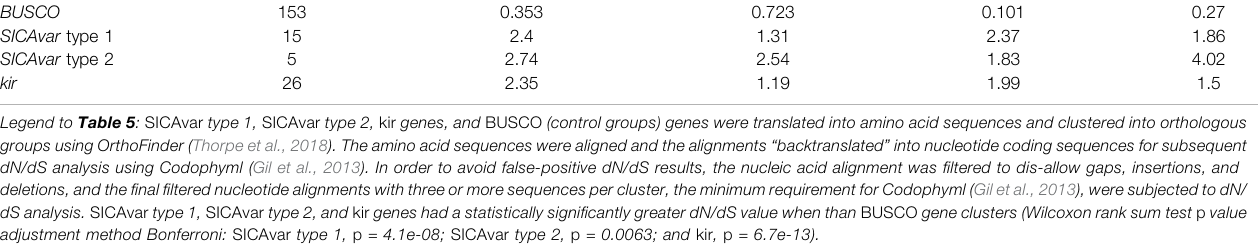
TABLE 5 | Non-synonymous versus synonymous (dN/dS) analysis of SICAvar type 1, SICAvar type 2, kir , and BUSCO gene clusters represented collectively in the StAPkA1H1, sks047, and sks048 draft genomes and the PKNH reference genome. Cluster group